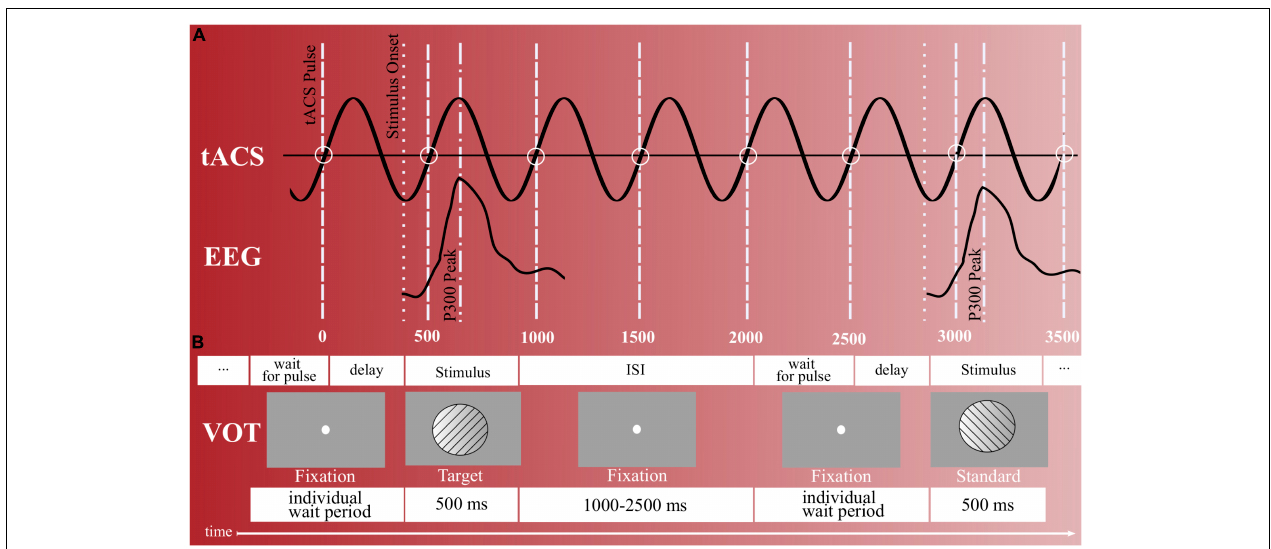
FIGURE 2 | Stimulus presentation and timing. (A) Synchronization between target trials and tACS peaks during the intervention block (actual stimulation). To coincide the participant’s elicited P300s with the tACS’s positive voltage peaks, NBS presentation waited for a pulse of the stimulator (wait for pulse). In addition, an individual delay existed that delayed until the tACS waveform was at the specific position so that its next positive peak would coincide with the next P300 peak triggered by a target stimulus. (B) Visual oddball task with right- and left-tilted gabor stimuli. Upon each left-rotated stimulus, participants were to respond with a left-hand button press and upon each right-rotated stimulus with a right-hand button press. In total, 400 gabor stimuli were presented, out of which 25% represented target stimuli and 75% standard stimuli. ISI = inter stimulus